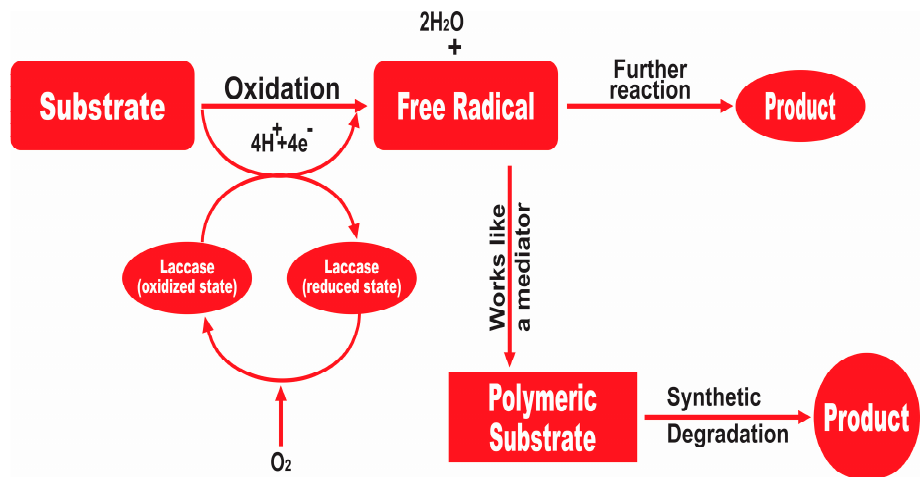
Figure 4. Catalytic action of laccase.